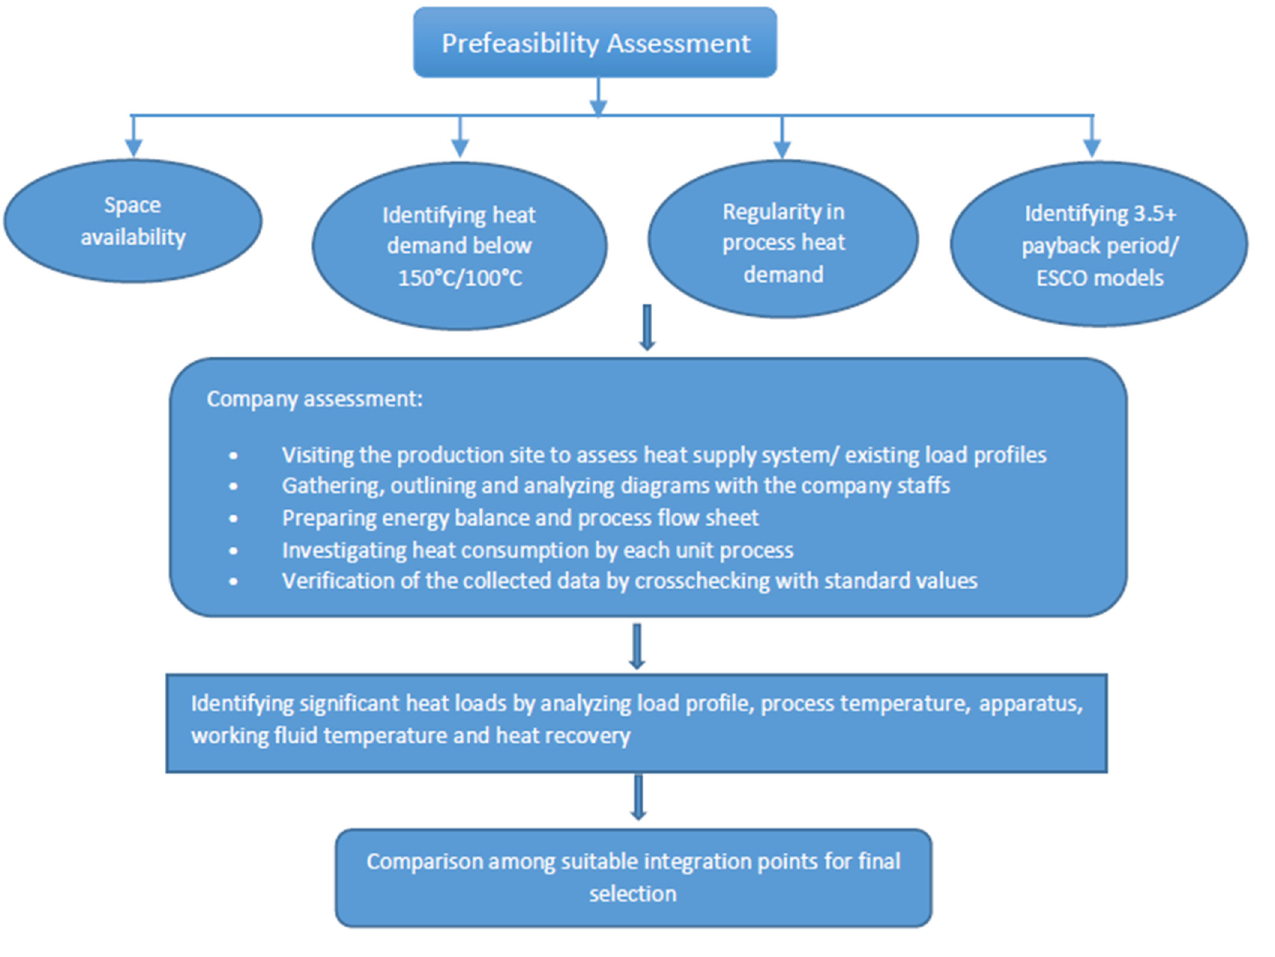
Figure 12. Steps towards the selection and identification of suitable integration points of solar process heat integration in industries. Modified from [63,64].